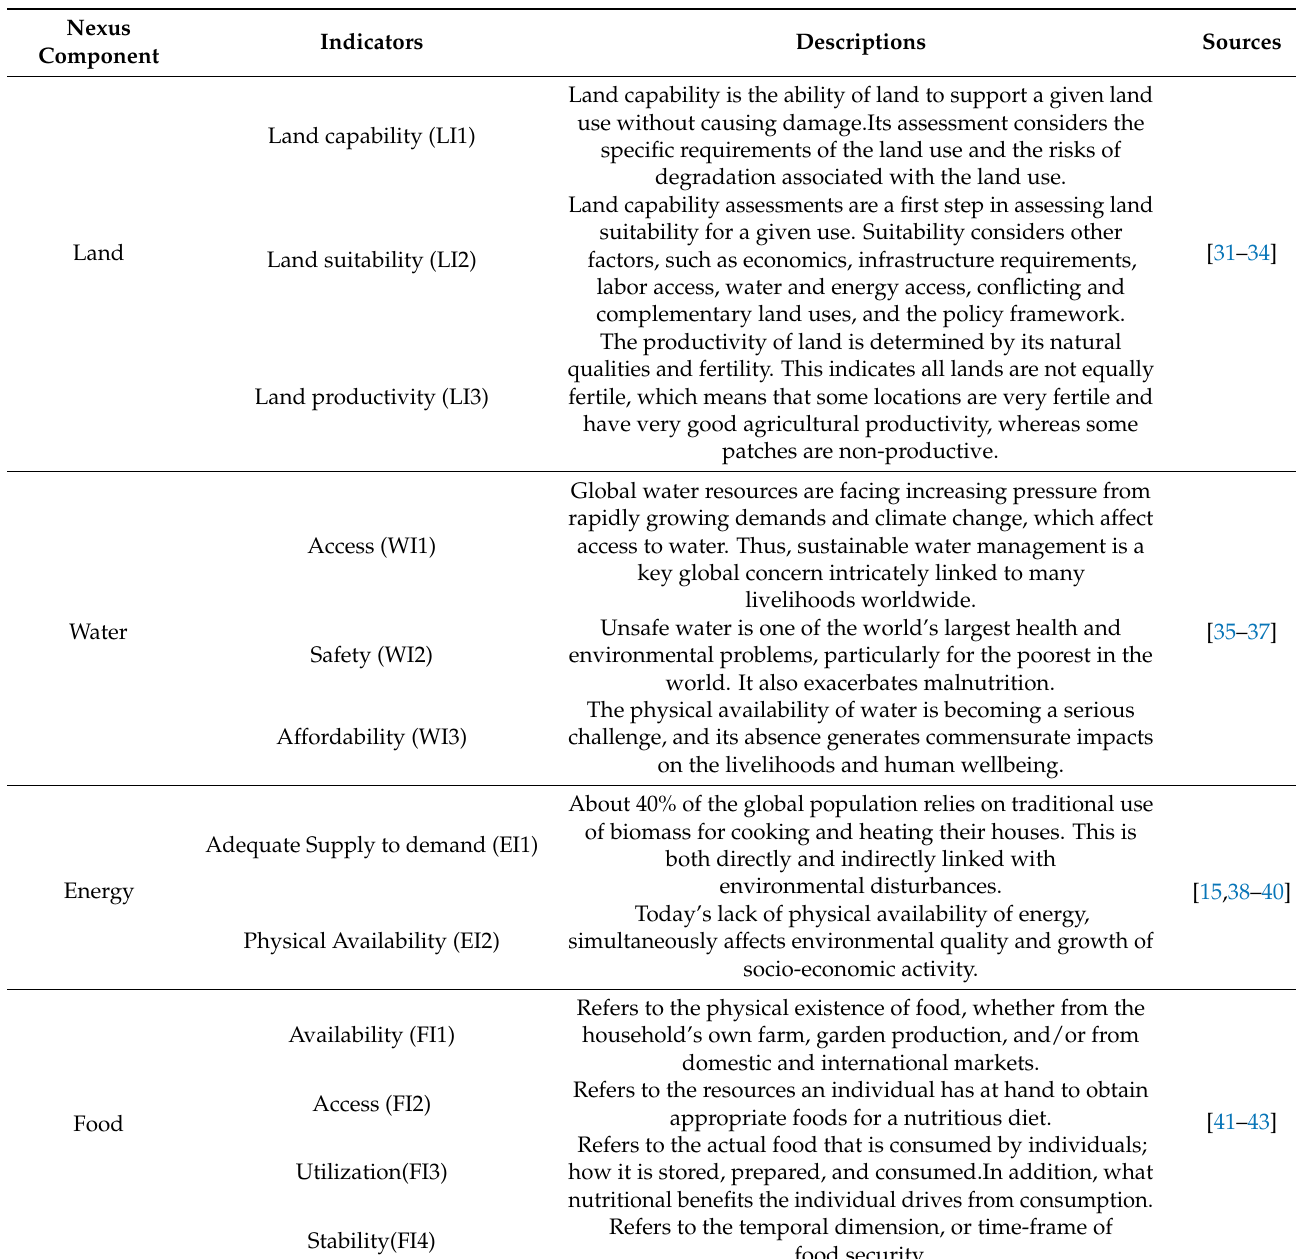
Table 1. Overview of the LWEF nexus indicators from the existing